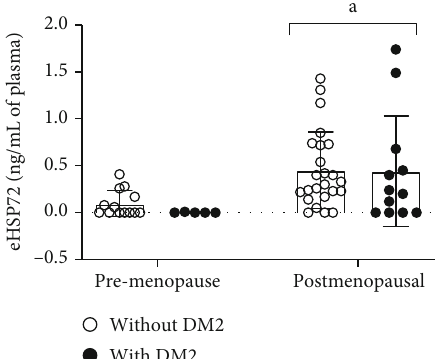
Figure 1: Plasma eHSP72 levels in premenopausal women without DM2 ( n = 13 ) and with DM2 ( n = 05 ) and postmenopausal women without DM2 ( n = 24 ) and with DM2 ( n = 12 ). Data were expressed in mean ± standard deviation . Two-way ANOVA, followed by Tukey. Menopause p = 0 : 0026 ; diabetes p = 0 : 6788 ; interaction p = 0 : 7374 . a vs. premenopause.